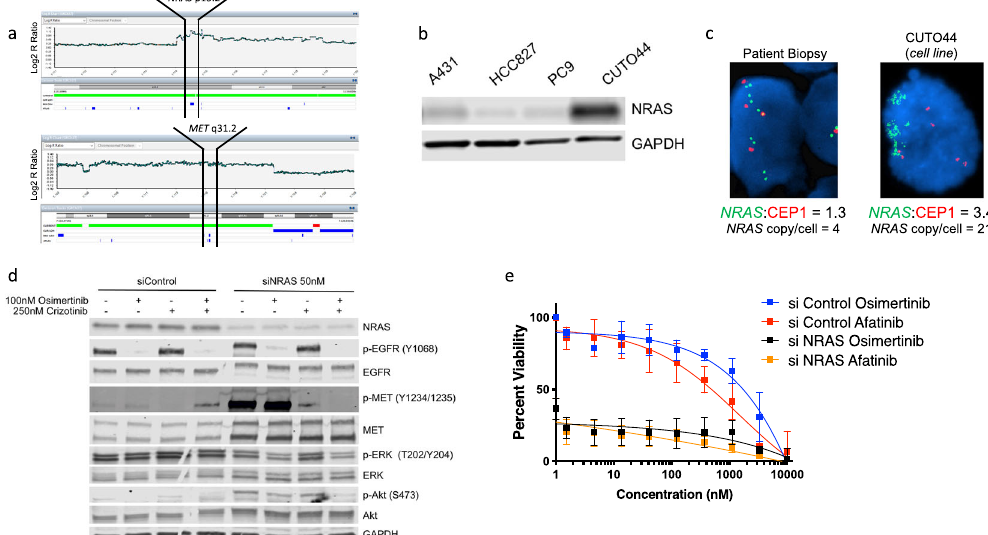
Fig. 3 Identi fi cation of NRAS gene ampli fi cation by CGH and sensitivity to NRAS knockdown combined with EGFR inhibition. a NRAS and MET ampli fi cation identi fi ed by CGH. CUTO44 genomic DNA was analyzed by CGH using Illumina CytoSNP-850K bead array. Images show chromosomes 1 and 7, highlighting the regions containing NRAS and MET . b NRAS protein expression in EGFR mutant lung cancer cell lines. Western blot showing NRAS protein levels in EGFR mutant lung cancer cell lines. Representative images are shown. c NRAS FISH on the patient biopsy after progression on erlotinib (left) and in the CUTO44 cell line (right) with NRAS probe in green and chromosome 1 centromere probes in red. d Protein expression changes following NRAS knockdown by siRNA. CUTO44 cells were transfected with 50 nM NRAS siRNA for 48 h, then treated with the indicated drug combinations for 2 h prior to lysis for western blot analysis of protein expression. Representative images, n = 2. e Cell viability following NRAS knockdown. CUTO44 cells were transfected with NRAS siRNA for 48 h prior to being treated with the indicated concentration of drugs for 72 h and viability was measured by MTS assay. Showing the mean ± SD, n = 3 biological